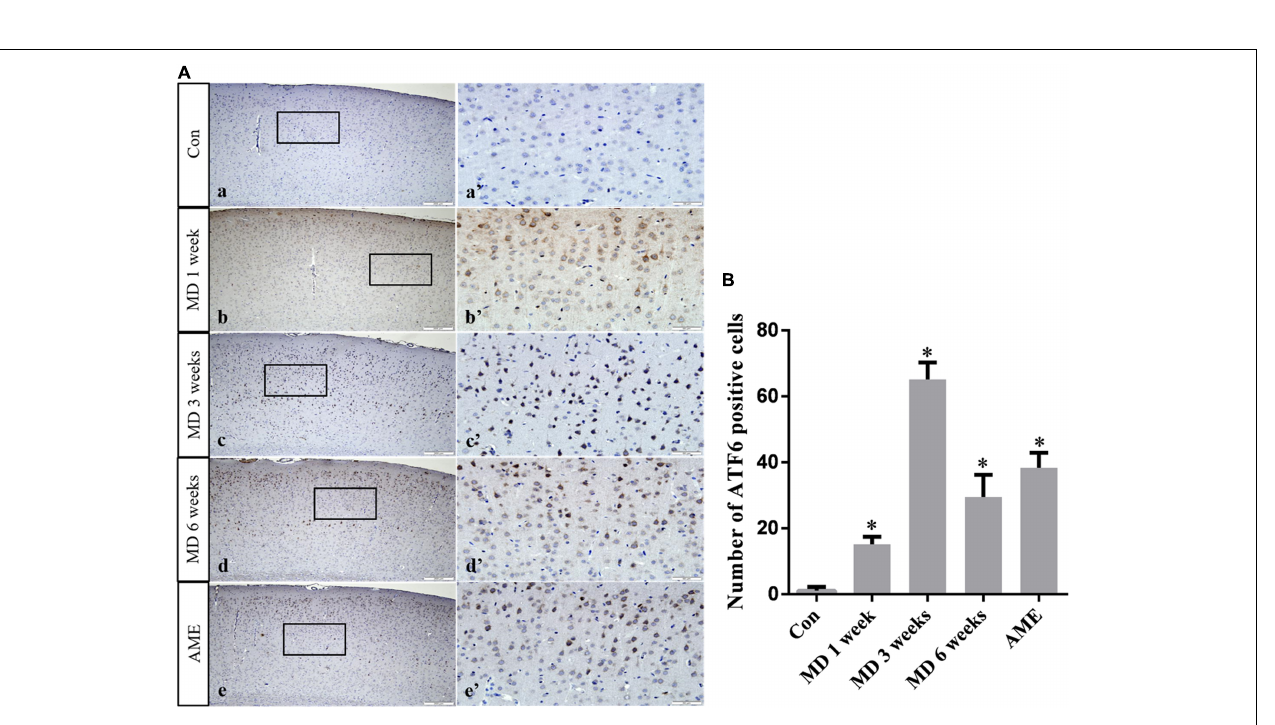
FIGURE 7 | (A) Representative images showing ATF6 immunohistochemistry in the cortex. Panels (a’–e’) are magnified areas of panels (a–e) . Bars = 200 µ m in panels (a–e) . Bars = 50 µ m in panels (a’–e’) . (B) Quantitative analysis of the number of ATF6 positive cells. The data are shown as mean ± SD, ∗ P < 0.05 vs. control group ( n = 6). MD, morphine dependence; AME, acute morphine